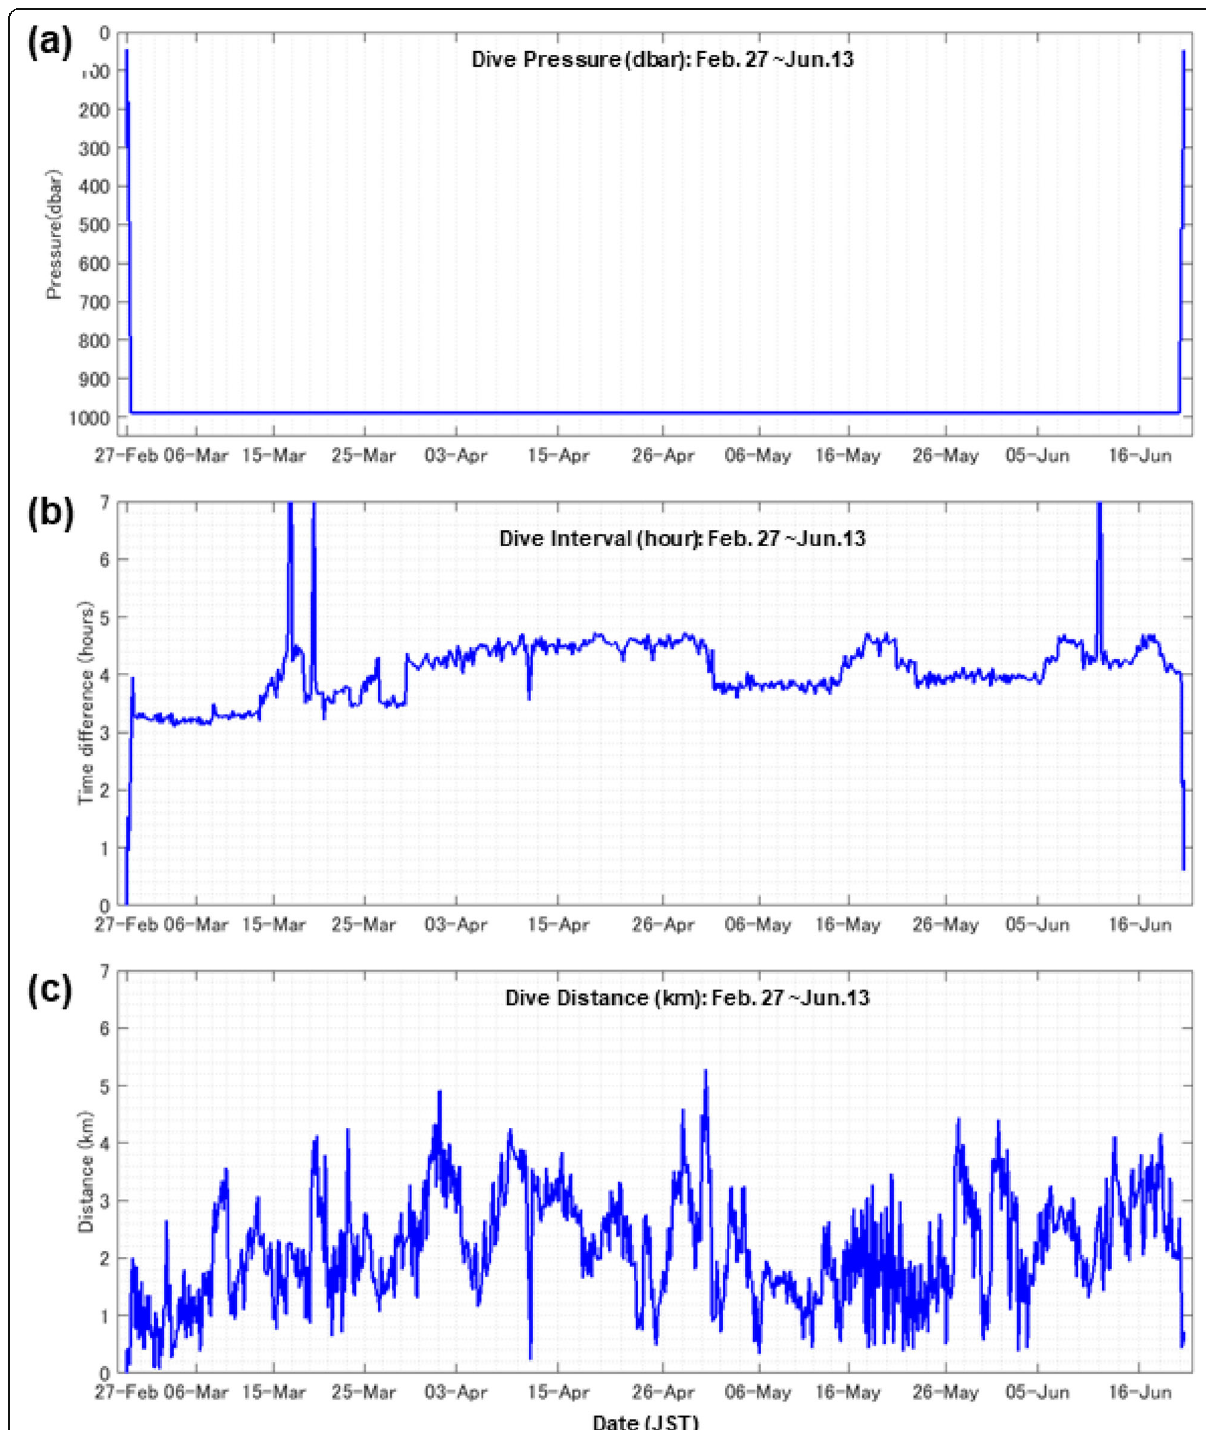
Fig. 2 a Dive pressure for each cast (dbar), b time interval for each cast (h), and c distance between each cast (km) through all Seaglider observations. Position, time, and pressure are measured at downward